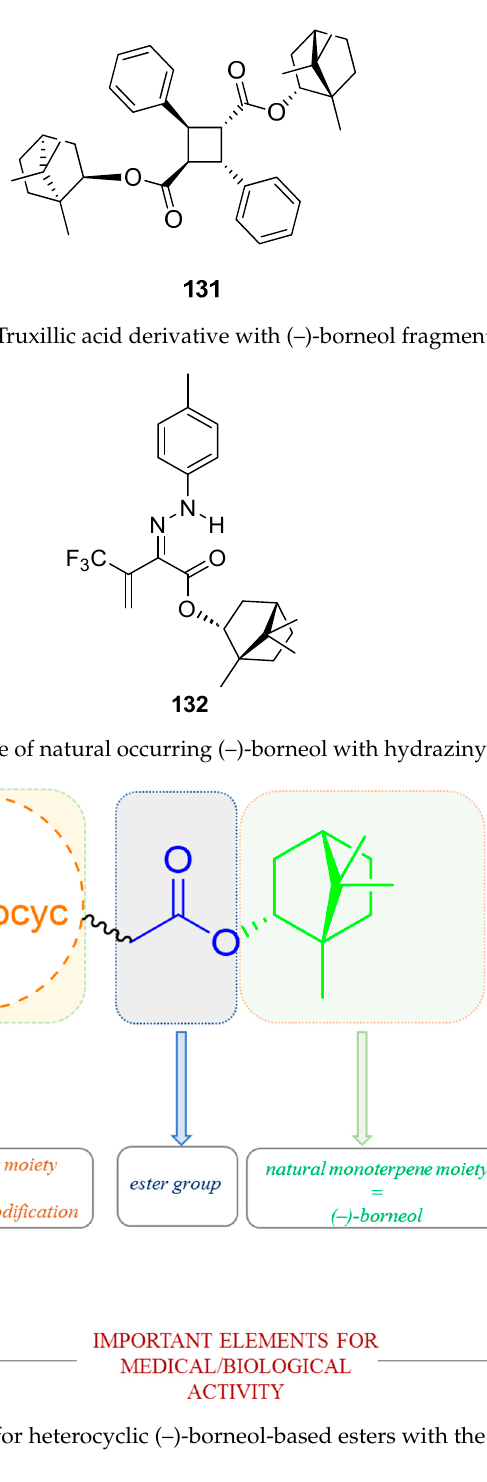
Figure 37. The design strategy for heterocyclic (–)-borneol-based esters with the effectiveness of the biological activity.